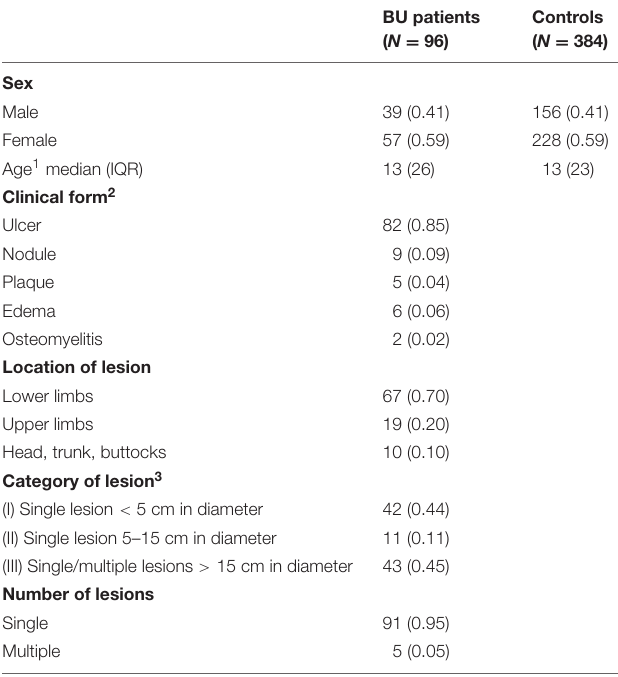
TABLE 1 | Baseline characteristics of BU patients.